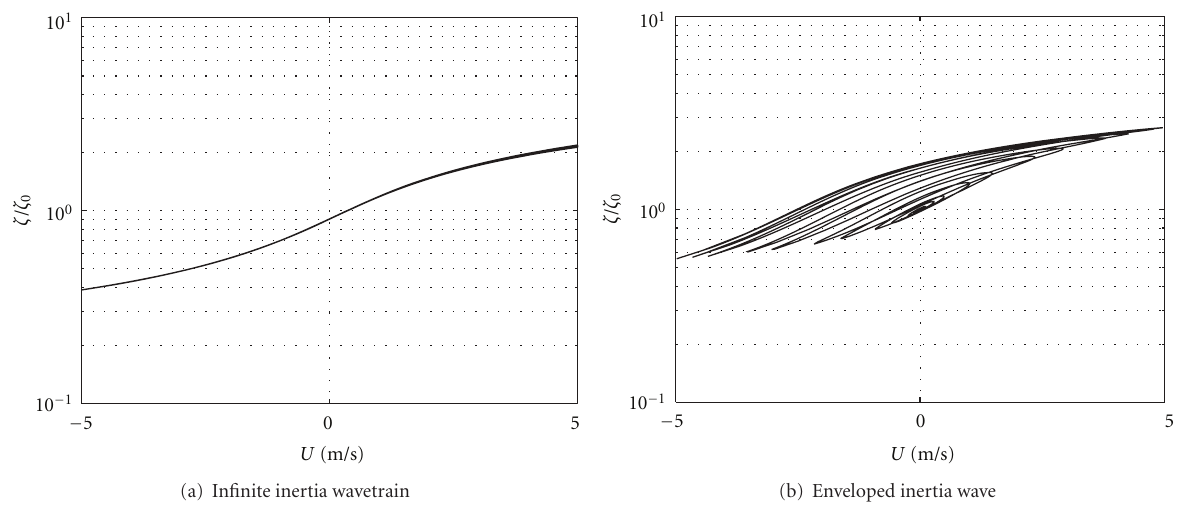
Figure 6: Normalized steepness of a short wave with m 0 /μ = 10 and k/μ = − 1 as it propagates through an inertia wave with U 0 = 5 m/s.